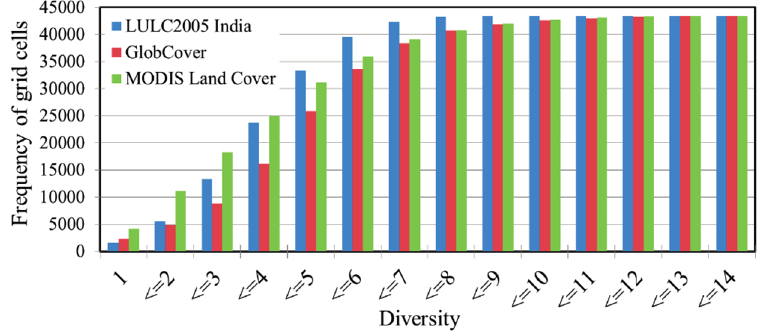
Figure 10. Comparative evaluation of LULC 2005 India product with MODIS Land Product and GlobCover using cumulative diversity of patch classes.